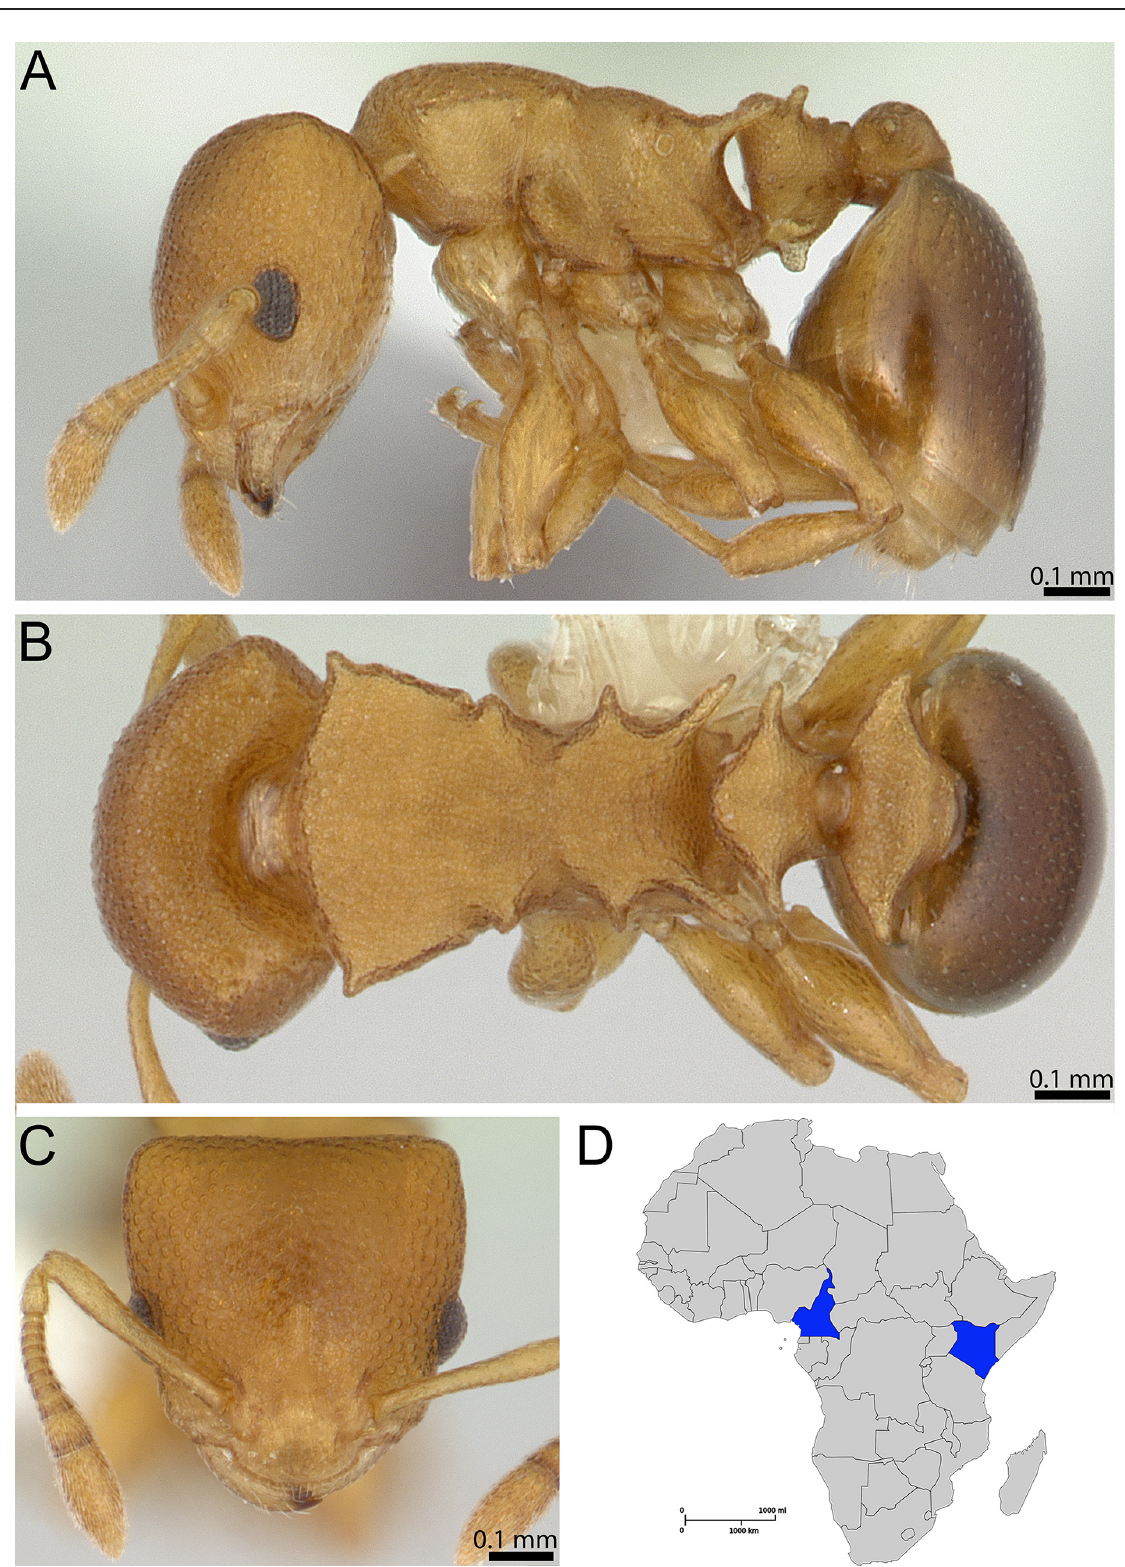
Fig. 5. Nesomyrmex cataulacoides (Snelling, 1992) (CASENT0178300). A . Body in profile view. B . Body in dorsal view. C . Head in full-face view. D . Map of Africa and Madagascar showing currently